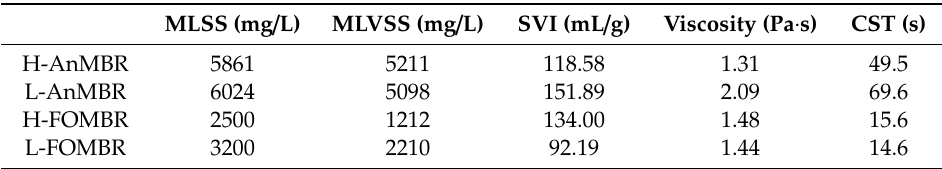
Table 3. The characters of active sludge in combined